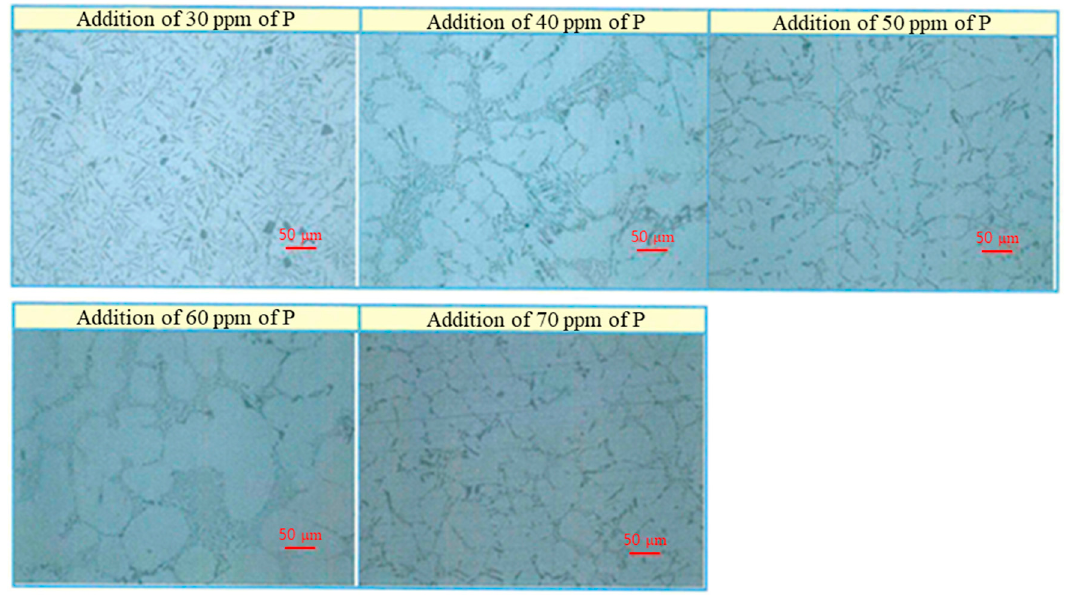
Figure 5. Comparison of Si structures formed by adding various amounts of P to the molten alloy. Grain refinement could not be achieved with the addition of only P; therefore, Sr was also added, and the changes in the alloy structure were examined. Figure 6 shows the Si crystals of the alloy to which varying amounts of Sr were added. Initially, 60 ppm P was added to the virgin Al to reduce the size of the Si grain; afterwards, Sr was added. When 50 ppm Sr was added, the acicular Si crystals remained almost unchanged. Furthermore, when 80 ppm Sr was added, the crystals were not evenly modified, resulting in an Si structure that was not refined, as the acicular Si crystals remained. However, when 120 ppm and 150 ppm Sr were added, although refined Si structures were confirmed in both cases, numerous fine Si crystals precipitated on the dendrite boundary surface. Finally, when more than 180 ppm Sr was added, small modified Si structures were observed. Be- cause molten Al 4 Si 2 Sr contained a considerable amount of Sr, the Si structure was suffi- ciently refined, i.e., Si did not precipitate as crystals and was refined on the boundary surface of the crystal, indicating that modification of the structure was successful [23,24].